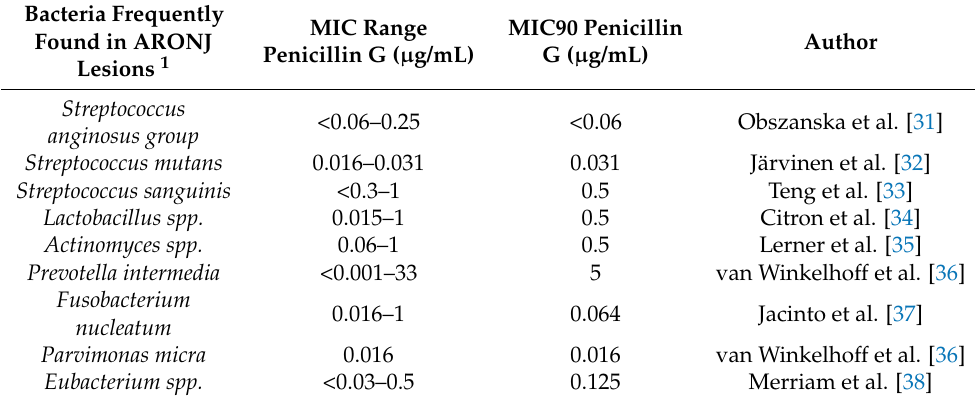
Table 2. Bacteria frequently found in antiresorptive agent-related osteonecrosis of the jaw (ARONJ) lesions and respective minimum inhibitory concentration (MIC/MIC90) for penicillin